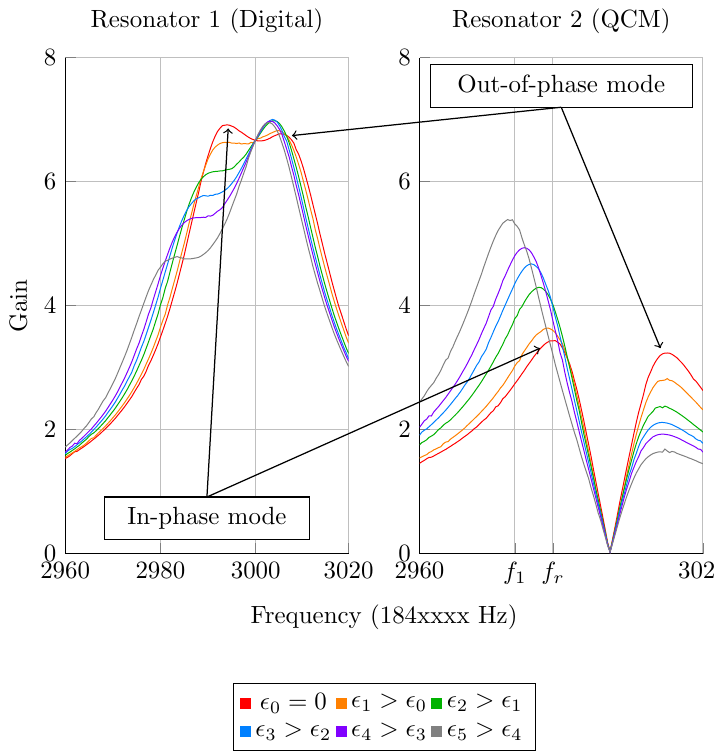
Figure 12. Experimental amplitude Bode diagrams of the coupled system digital-QCM for a coupling ratio κ = 0.15 and different mass perturbations (cid:101) i applied on resonator 2, which is excited with a phase rad. of π 2